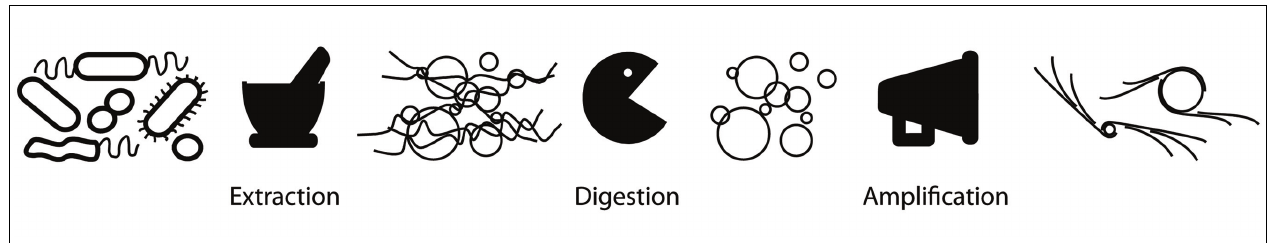
FIGURE 1 |Workflow for mobilome analysis as used in Kav etal. (2012), Li etal. (2012), Jørgensen etal. (2014), and Norman etal. (2014). Initial careful DNA extraction is followed by digestion of linear and nicked DNA with exonuclease and unspecific but selective amplification of circular DNA using multiple displacement amplification